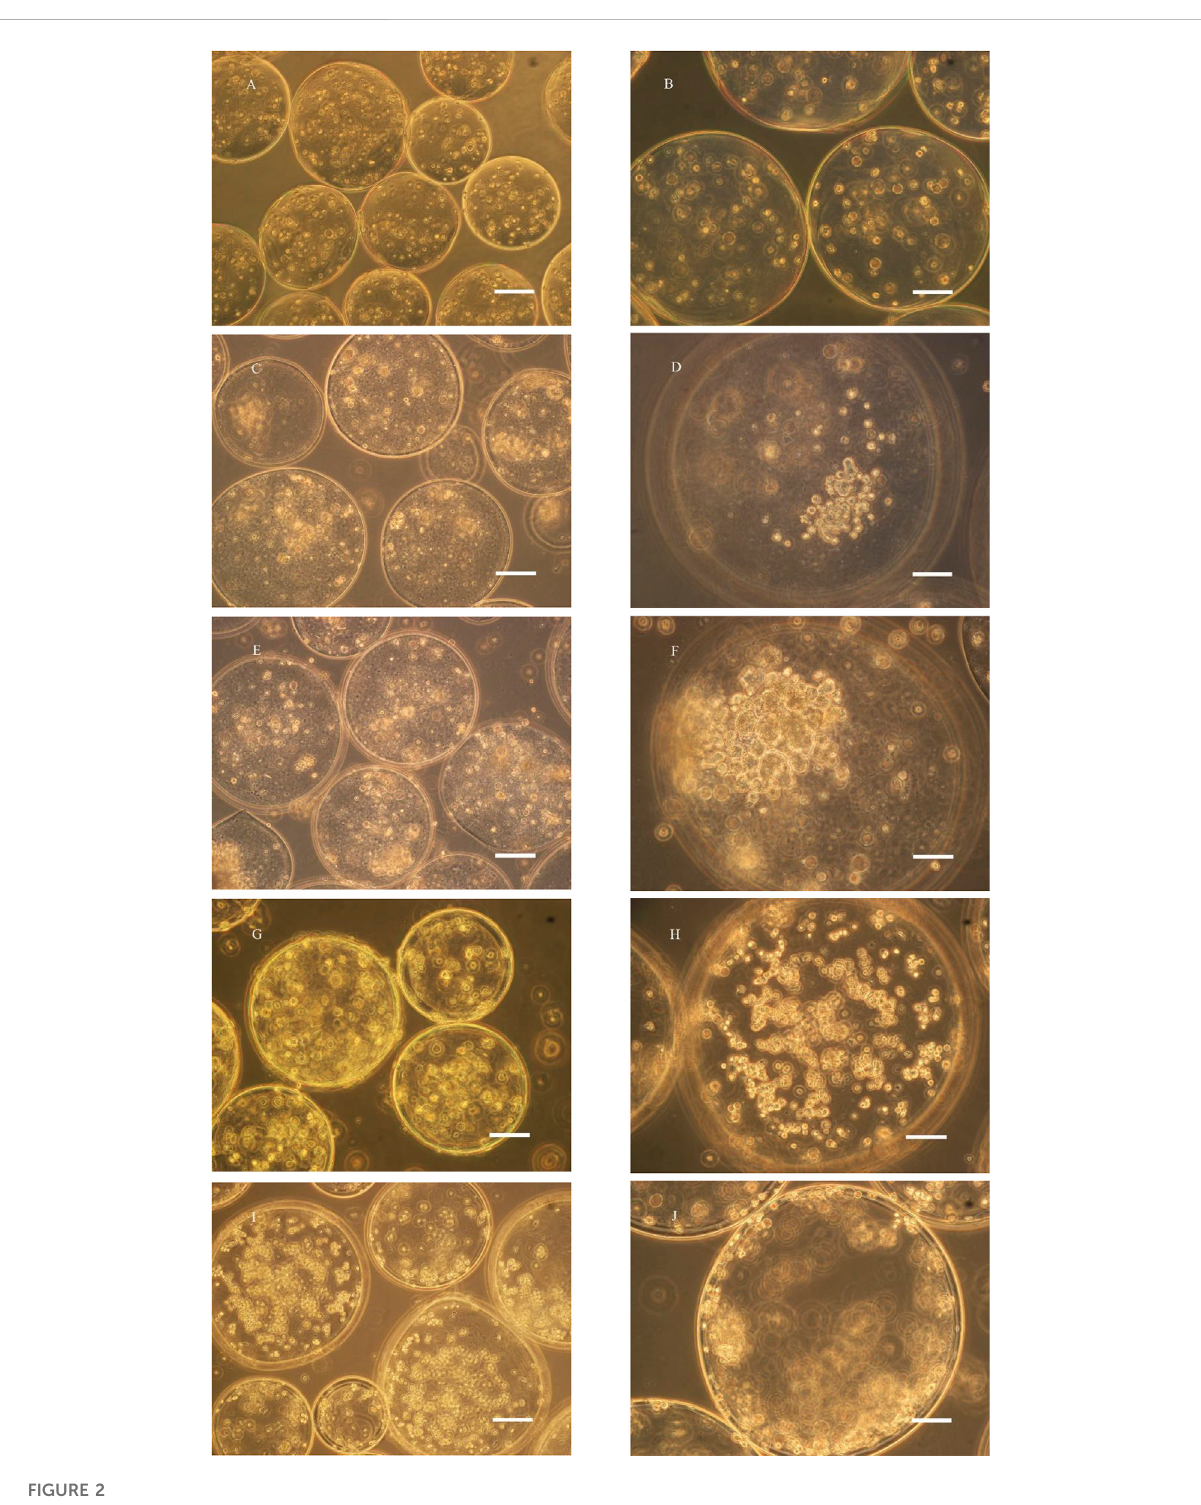
FIGURE 2 Microscopy photograph of microencapsulated BRL-3A cultured in rotary (C – F) , static (G, H) and shaking (I, J) cell culture system (left: ×200, bar: 100 μ m; right: ×400, bar: 50 μ m; (A, B) : 0 d; (C, D) : 7 d; (E – J) : 14